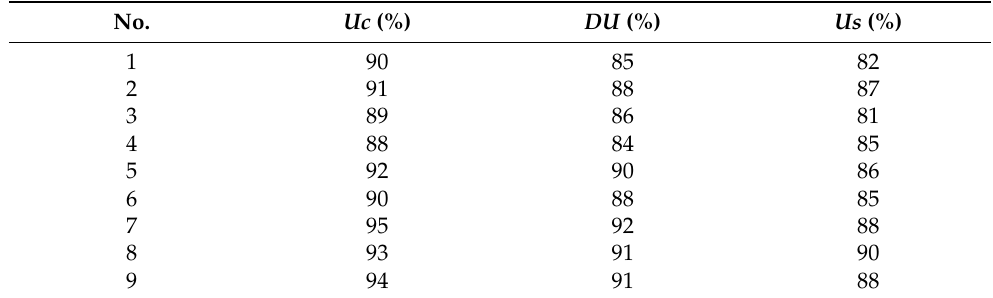
Table 4. Comparison of fertilization uniformity under different water and fertilizer flow